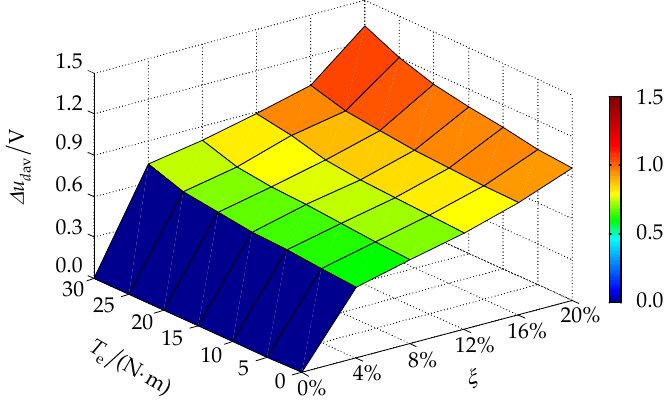
Figure 12. The variation diagram of ∆ u d av with the percentage for the number of short-circuited turns and the electromagnetic torque.